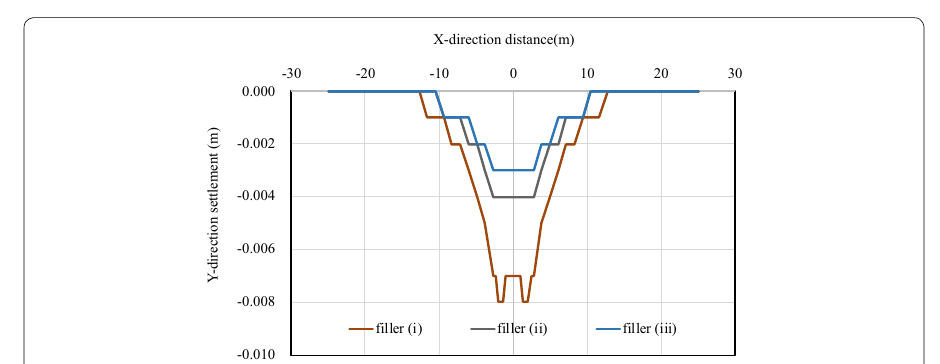
Fig. 7 Y-direction settlement on ground surface with fillers (i), (ii) and